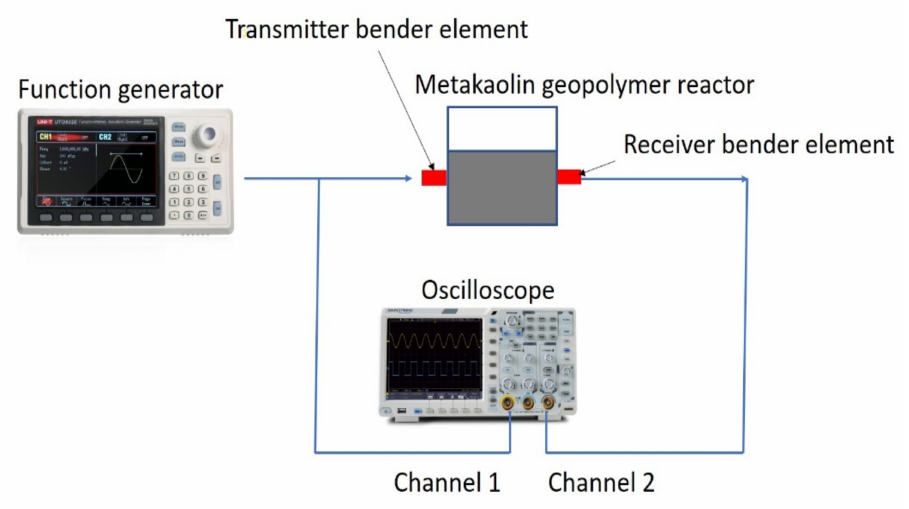
Figure 3. Bender element test